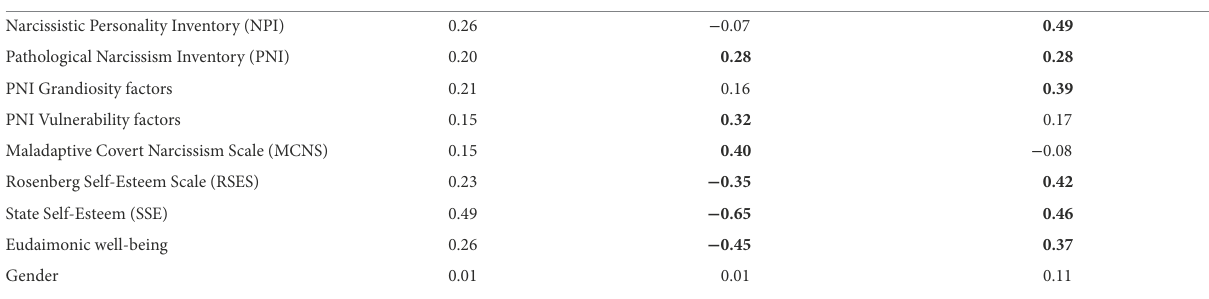
TABLE 6 Associations of the PNI-S in Sample 3: Regression based on averaged scores from the momentary